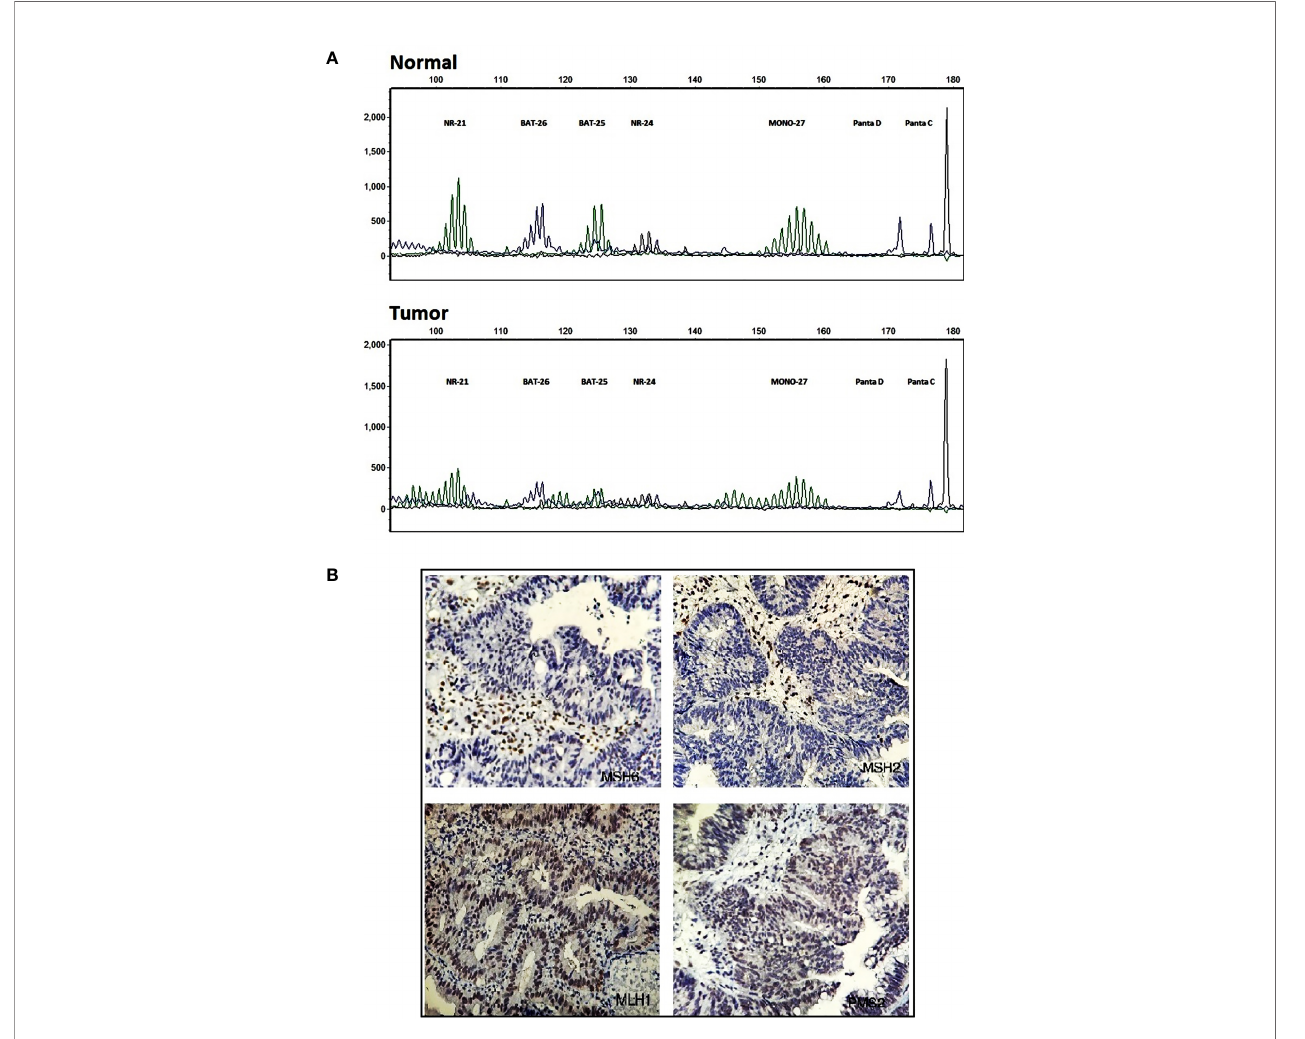
FIGURE 2 | Molecular testing results. (A) Fragment pro fi le of the Promega MSI analysis system (GeneMarker v1.85 Software). Instability is detectable at tumoral tissue (bottom) compared to normal at BAT-25, BAT-26, NR-21, NR-24, and MONO27 markers. (B) Immunohistochemistry staining for MMR system proteins, MSH2, MSH6 (mutant) MLH1, PMS2 (intact), in tumoral